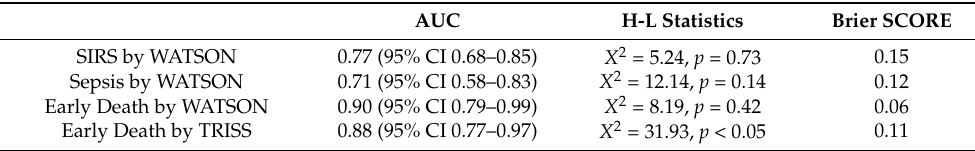
Table 3. Results of the ROC analysis for WATSON versus